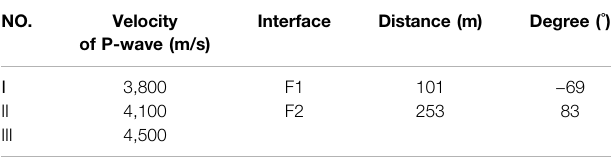
Frontiers in Earth Science |